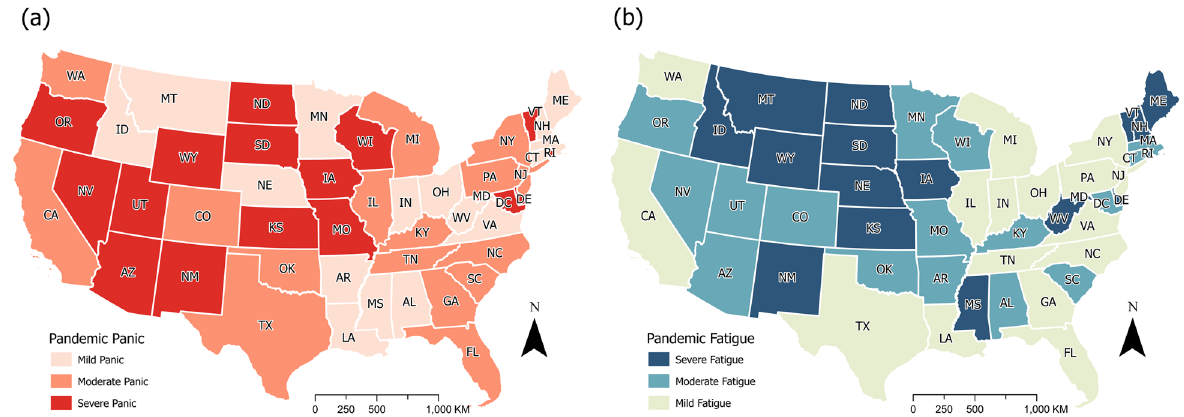
Fig. 2 Pandemic panic ( a ) and pandemic fatigue ( b ) by